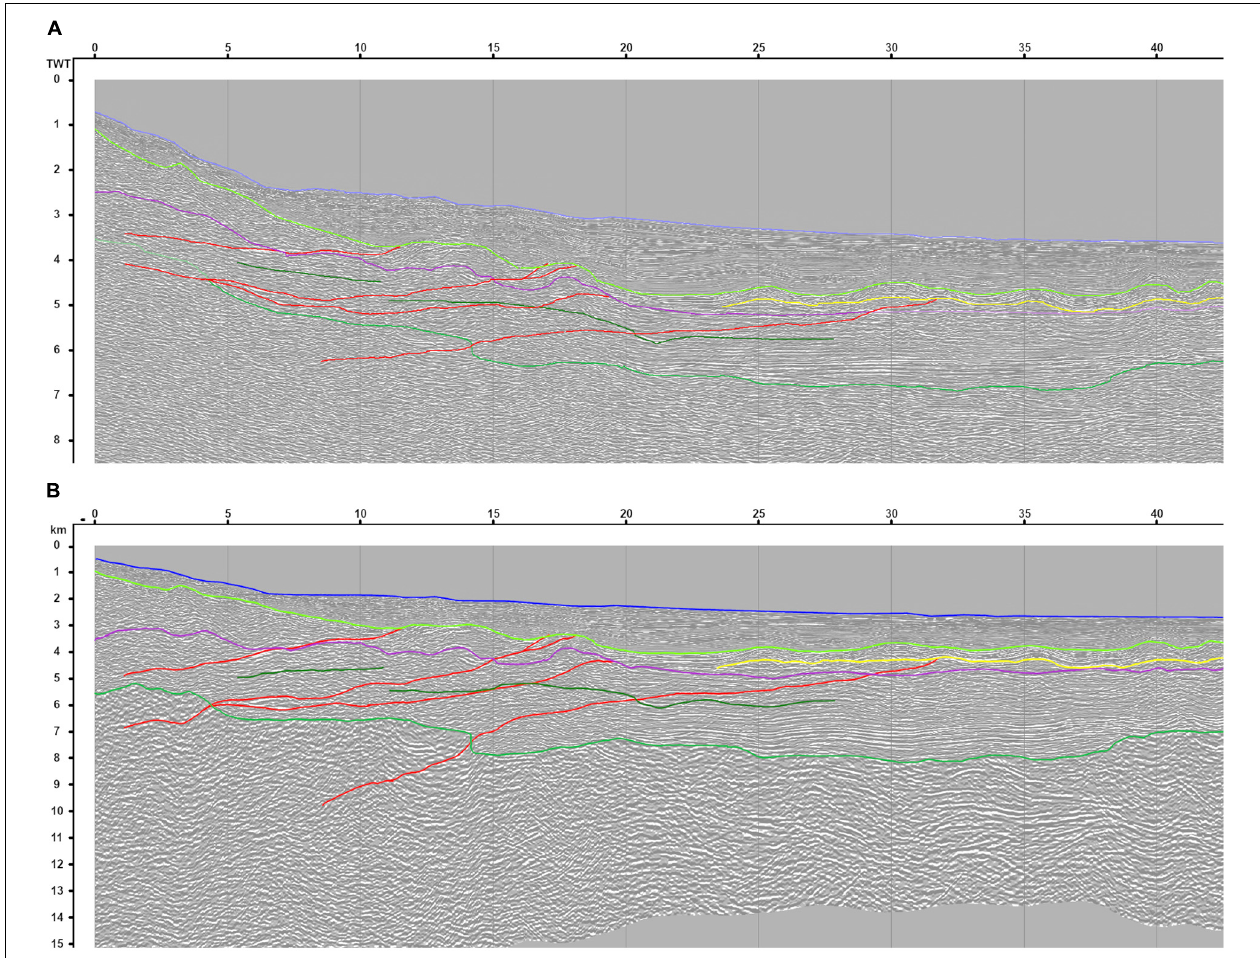
FIGURE 5 | Extraction of Section 5 (East Jijel, Lesser Kabylia, Figure 2 ) without (A) or with (B) depth conversion and how it modifies the perception of the true geometry of the faults and of the seismic reflectors of the